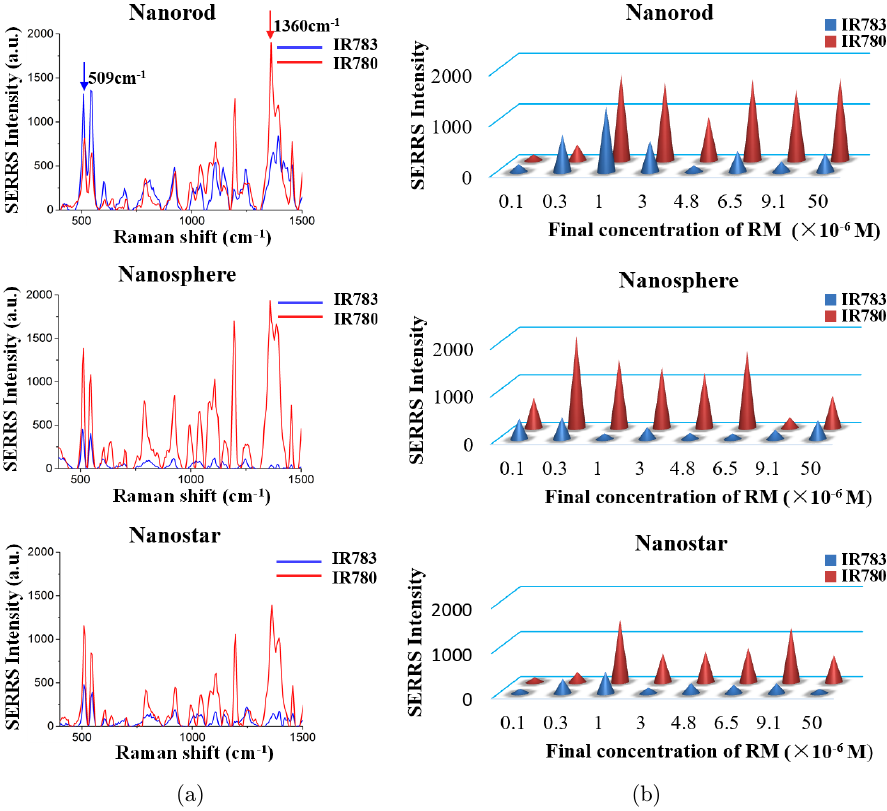
Fig. 4. The chemical structure of reporter molecule remarkably changes signal intensity of gold nanoparticle based SERRS probes. (a) The Raman spectra of the SERRS nanoprobes with di®erent substrate morphologies and RM at their optimal concentration. (b) SERRS signal intensity of nanoprobes as a function of RM concentration and types. The Raman intensities of the gold nanoparticles were quanti¯ed from their strongest peak at 509 cm (cid:2) 1 (for IR783) and 1360 cm (cid:2) 1 (for IR780).